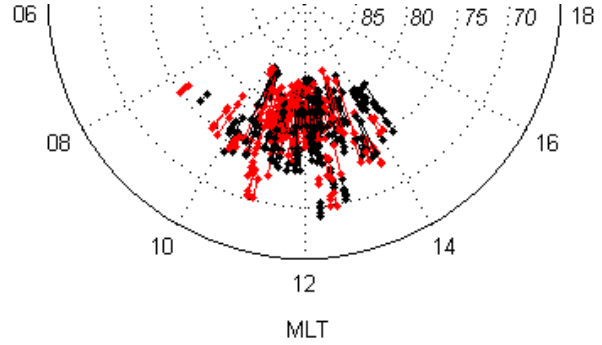
Fig. 3. Location of all cusp crossings as a function of magnetic lo- cal time (MLT) and invariant latitude (ILAT). Black and red desig- nate crossings which occurred in the Northern and Southern Hemi- sphere, respectively.